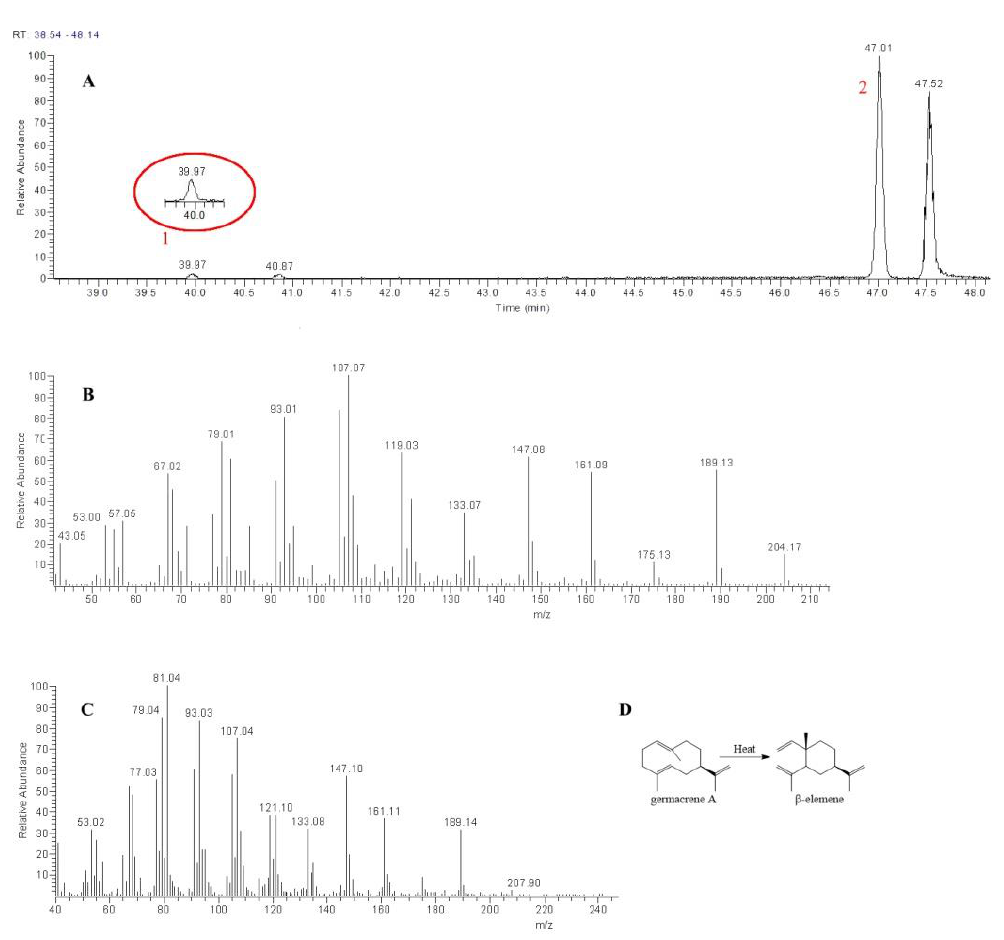
Figure 6. Ls GAS gene catalyzed the production of GA from FPP. ( A ) A GC-MS ion chromatogram, in which peak 1 corresponds to β -elemene and peak 2 corresponds to GA. ( B ) Fragment ion of GA. ( C ) Fragment ion of β -elemene. ( D ) Rearrangement of germacrene A to β -elemene through the application of heat.